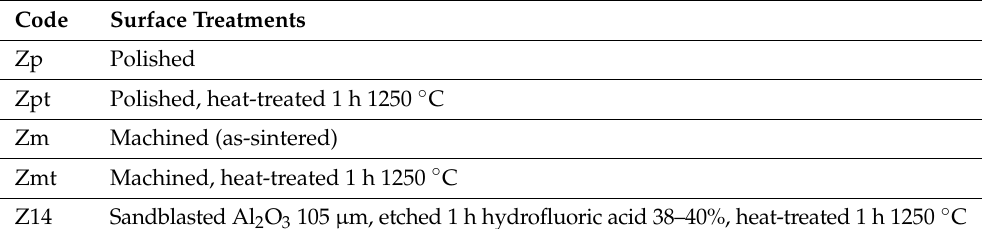
Table 1. Surface treatments of zirconia surfaces for the respective